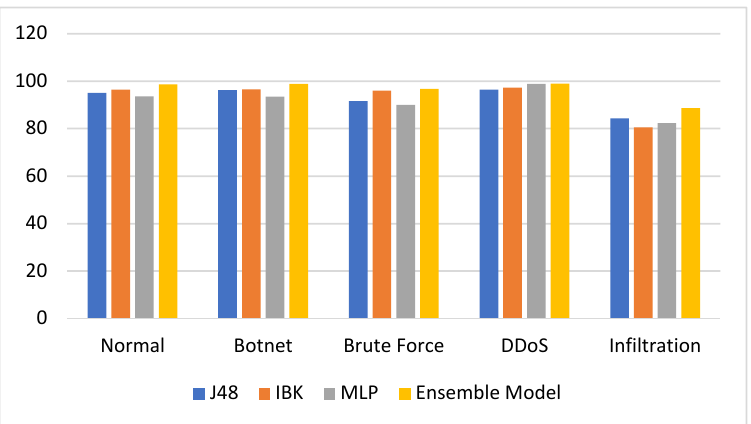
Figure 6. Accuracy of ensemble versus single classifiers. Table 7. Individual and ensemble performances.